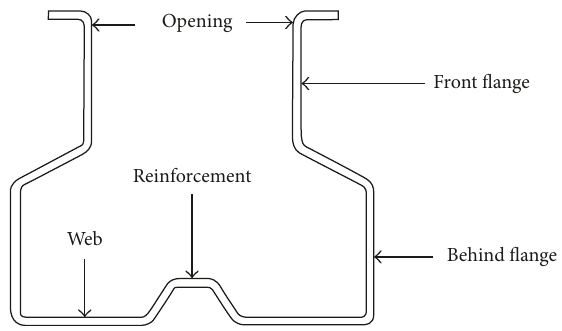
Figure 13: Section details of column.